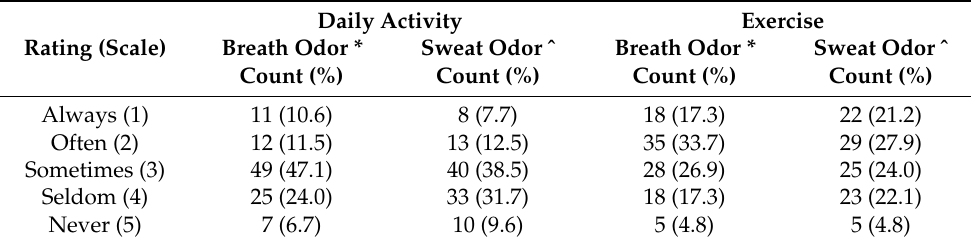
Table 5. Perceived air quality (PAQ) measured with perceived unpleasant breath odor and unpleasant sweat